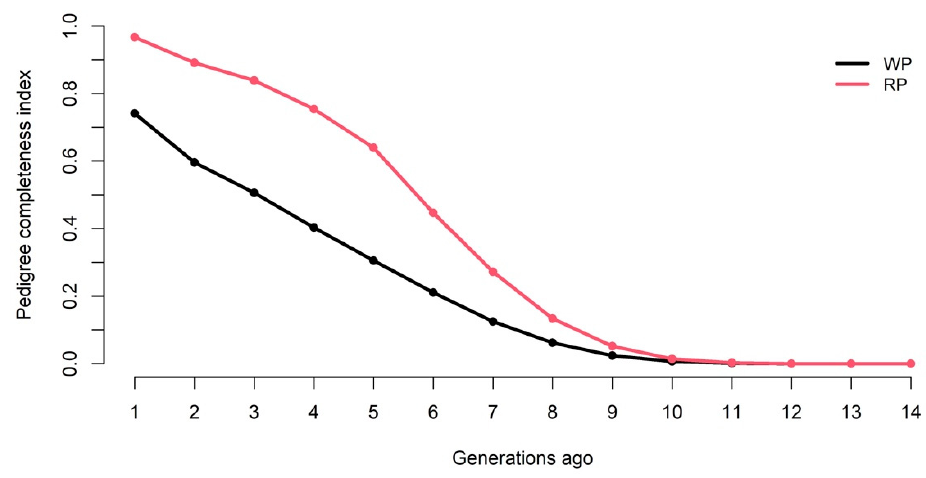
Figure 2. Pedigree completeness index in the whole (WP) and reference (RF) populations.